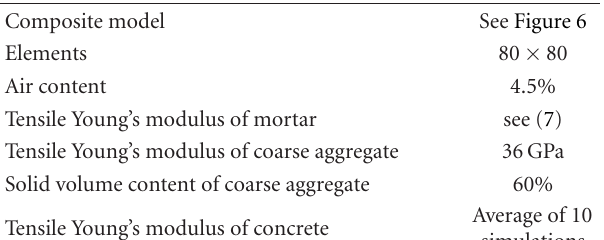
Table 5: Conditions for simulation of tensile Young’s modulus.